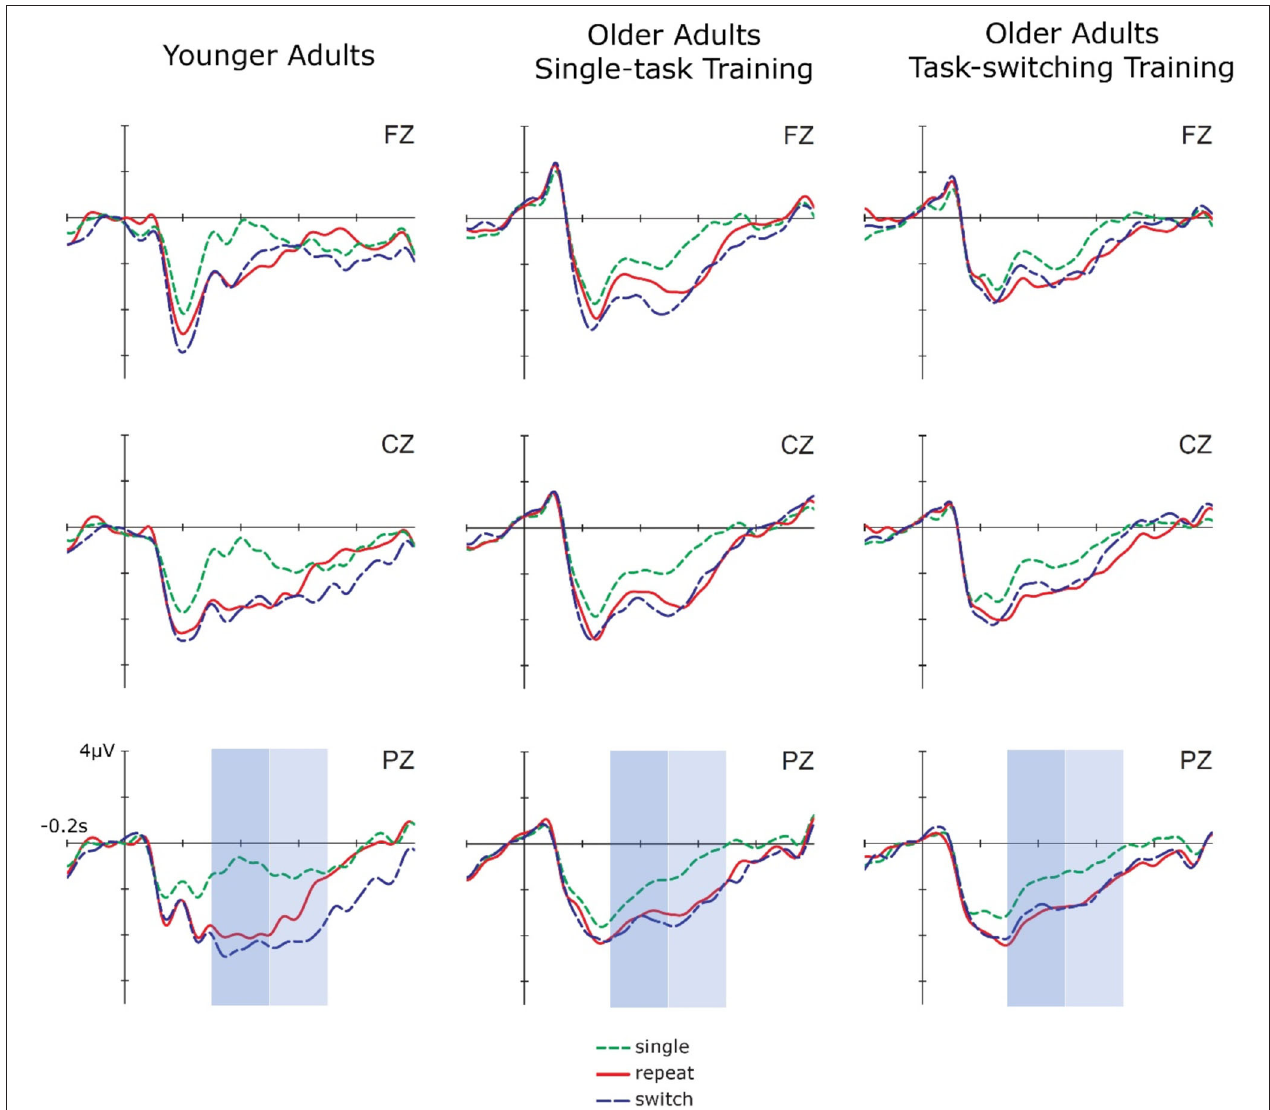
FIGURE 1 | Cue-locked ERPs for single, repeat, and switch trials at pretest for younger adults, older adults in the single-task training, and older adults in the task-switching training group displayed at electrodes Fz, Cz, and